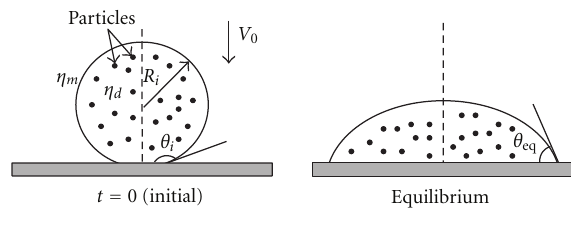
Figure 1: A schematic representation of a particulate droplet spreading. The initial drop contacts the solid surface and the particles are distributed inside the drop. The drop spreads with inertial force and then spreads to an equilibrium state.